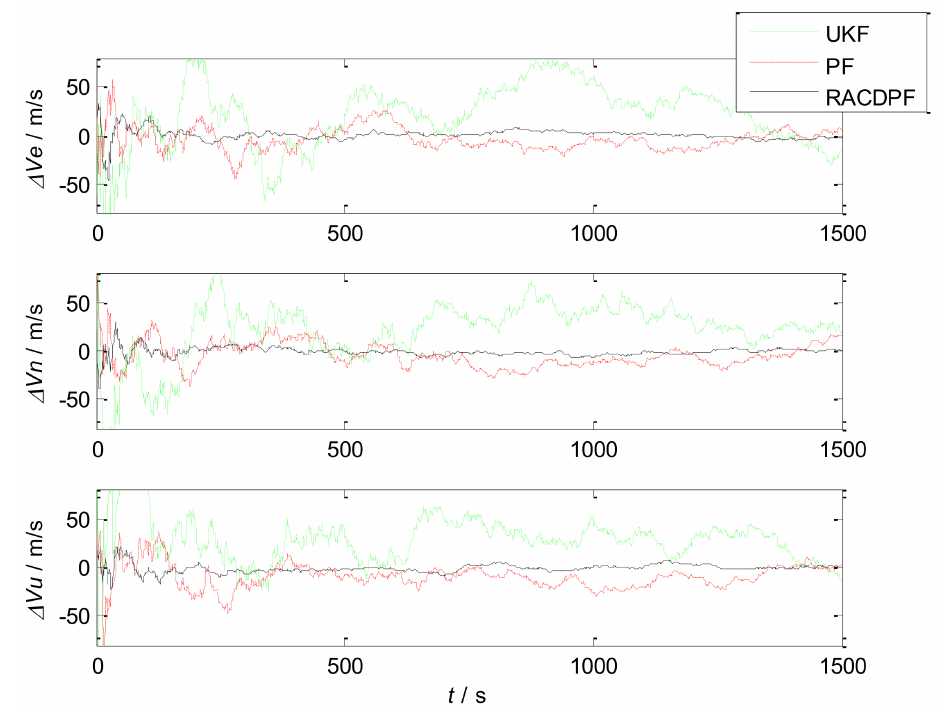
Figure 8. Velocity errors of the three filtering algorithms ( M = 200).